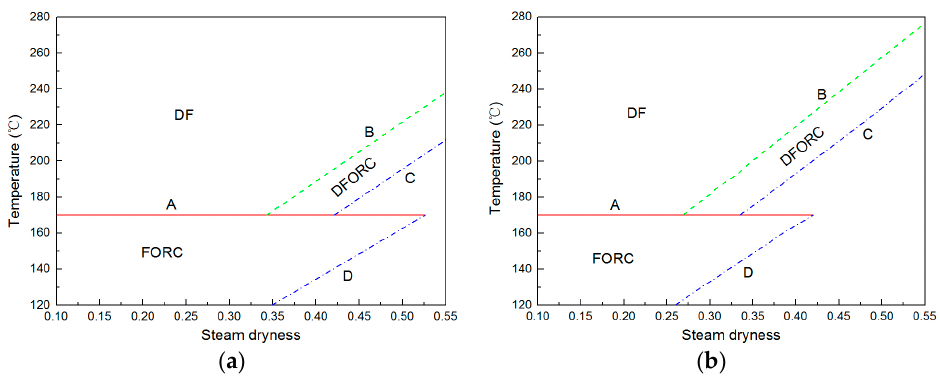
Figure 11. Selection maps for power generation systems (DF, FORC, and DFORC) used for enhanced geothermal systems (EGS), generated based on the net power increase ratio of ( a ) 10% and ( b ) 15%, respectively.